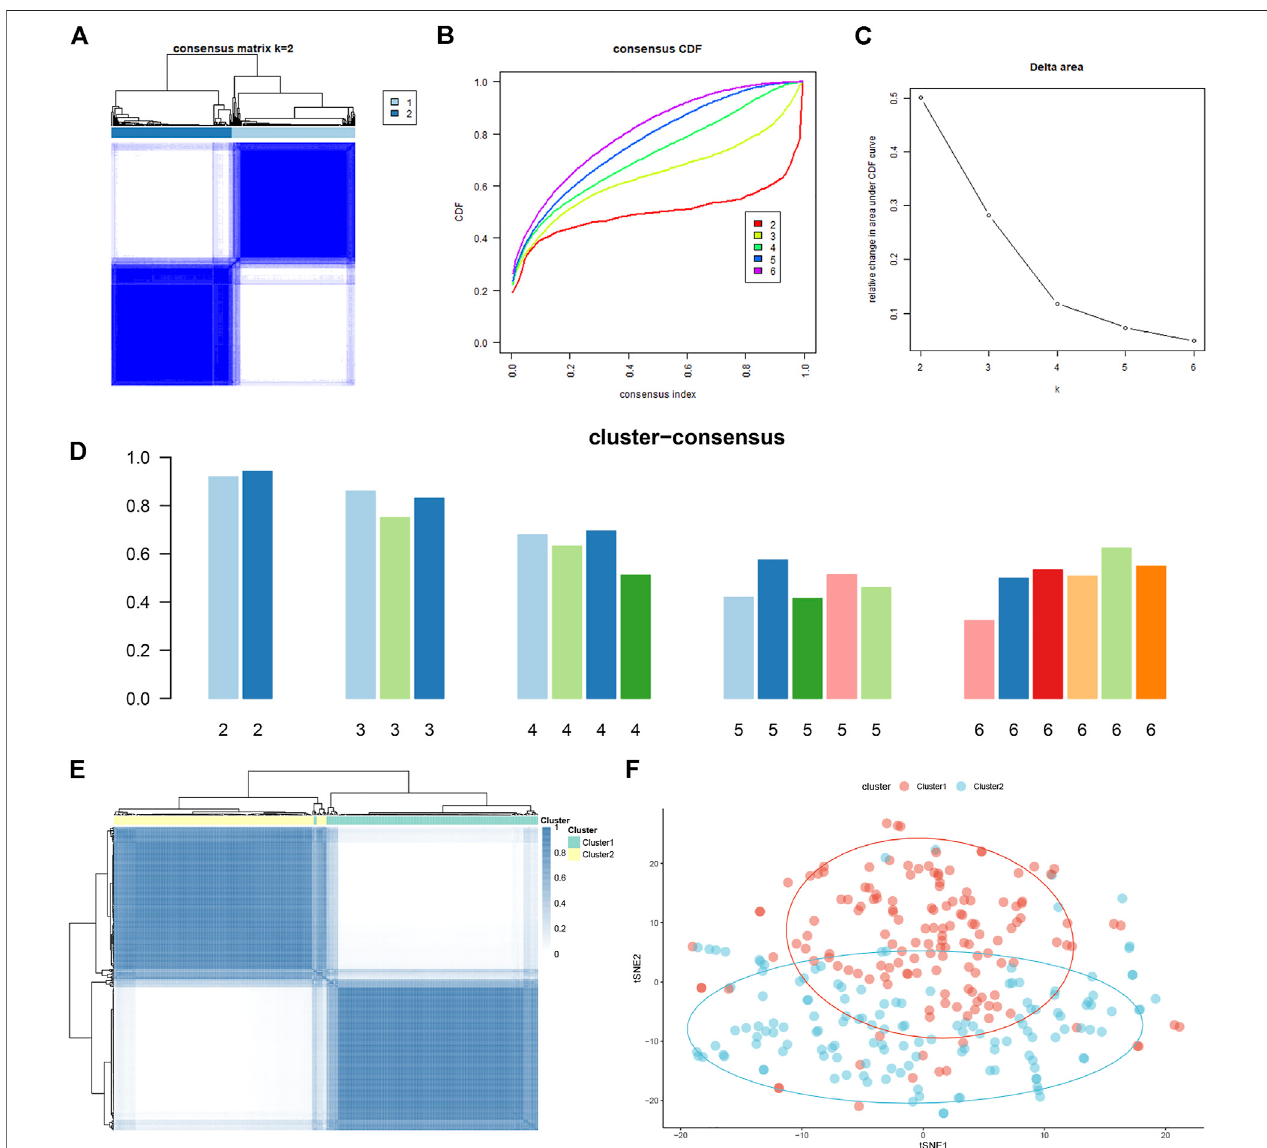
FIGURE 4 | Identi fi cation of molecular clusters based on FRGs in ASD. (A) Consensus clustering matrix when k = 2. (B – E) Cumulative distribution function (CDF) curvesof clustering (B) , CDF delta area curves (C) , consensus clustering score of each cluster (D) , and non-negative matrix heatmap (E) for veri fi cation ofthe clustering results. (F) t-SNE visualizes the distribution of two